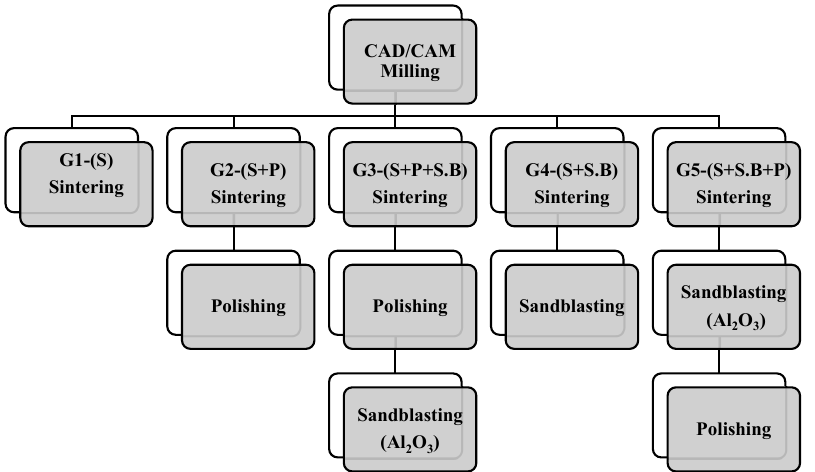
Figure 1. Categorisation of the Y-TZP specimens based on the different post-fabrication processes.